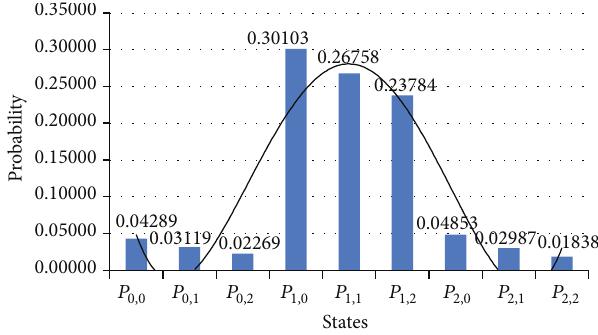
Figure 5: Fixed-path example with overlapping networks.